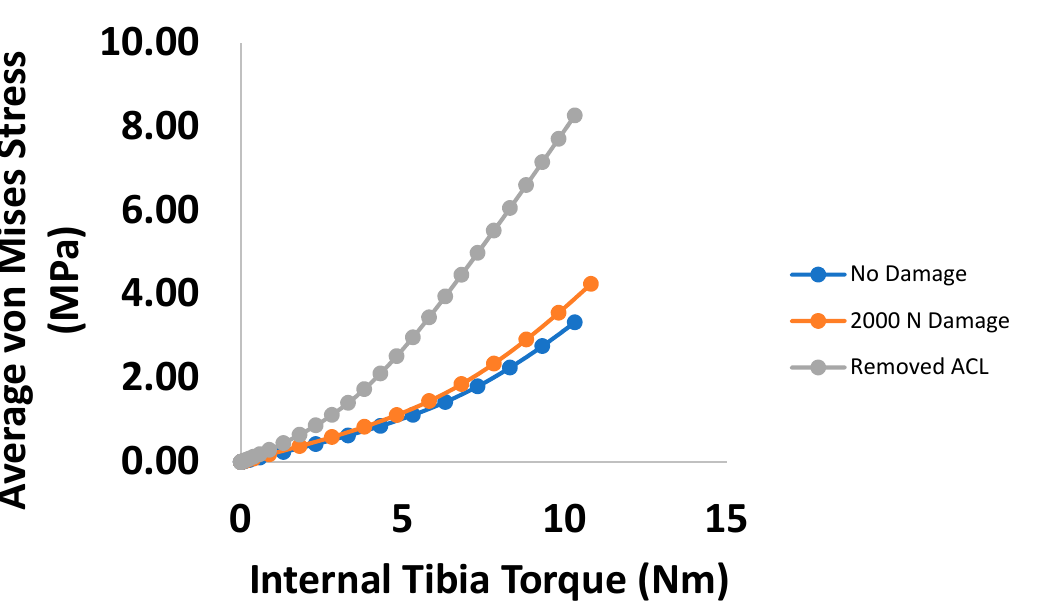
Figure 11. Plot of average LCL mid-substance von Mises stress (MPa) versus internal tibial torque for the three prescribed damage cases.